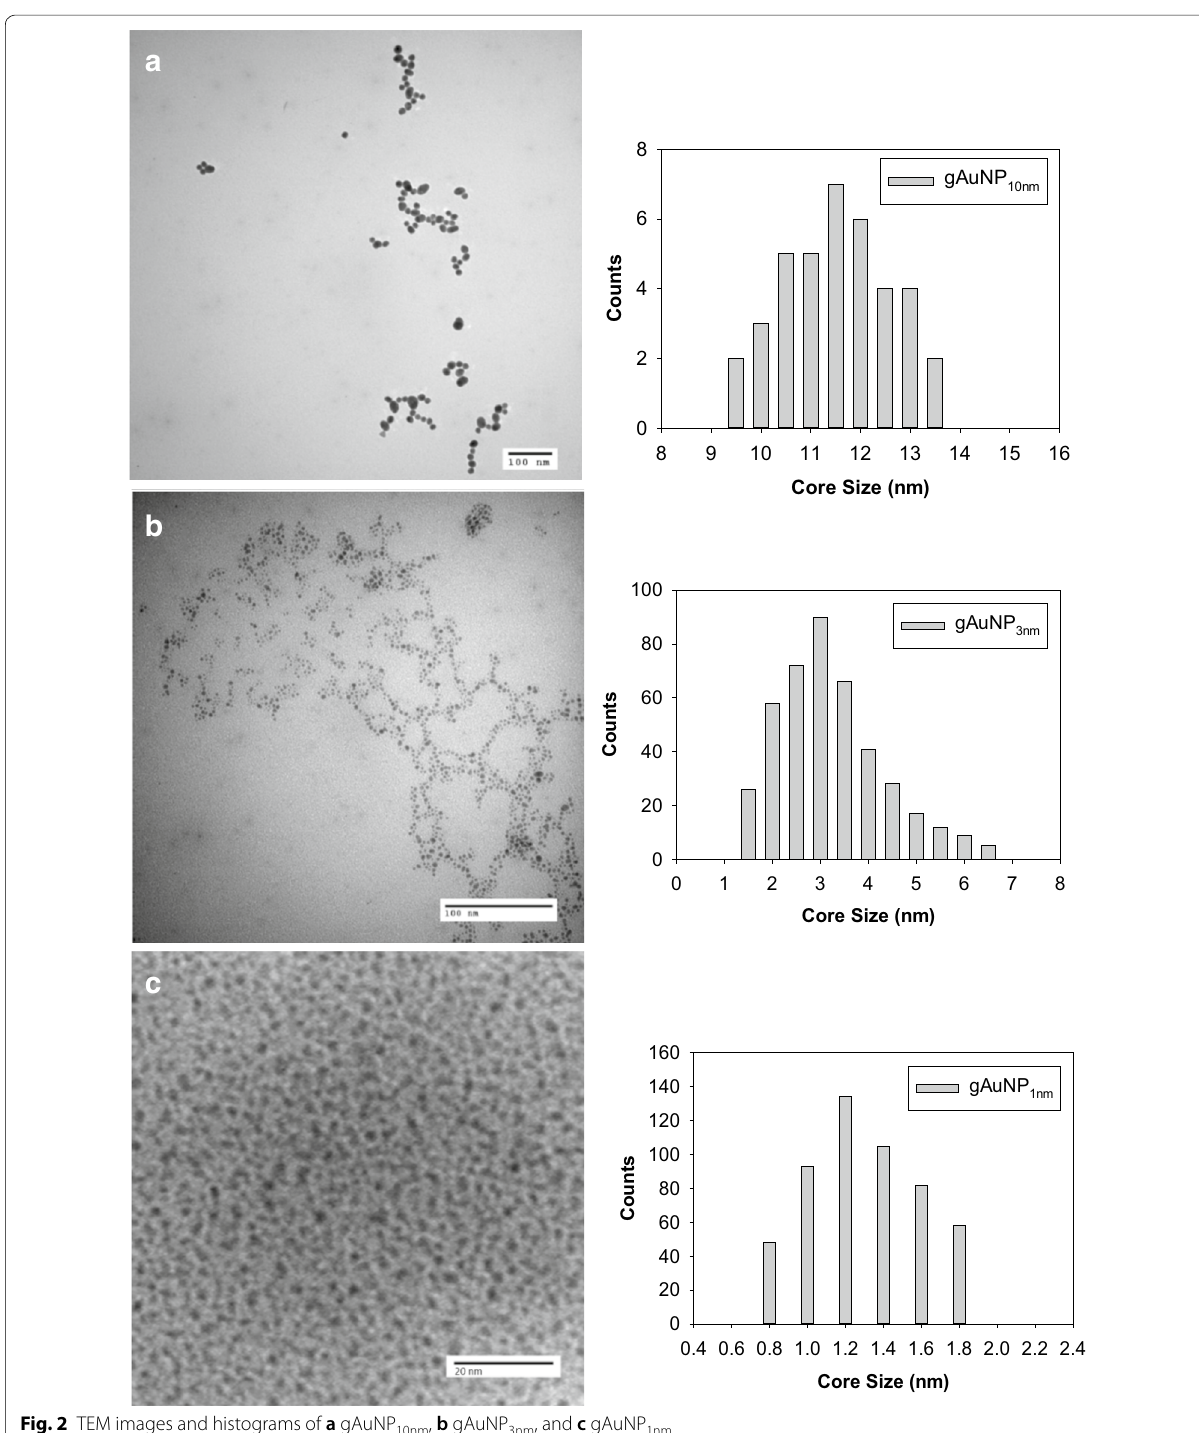
Fig. 2 TEM images and histograms of a gAuNP 10nm , b gAuNP 3nm , and c gAuNP